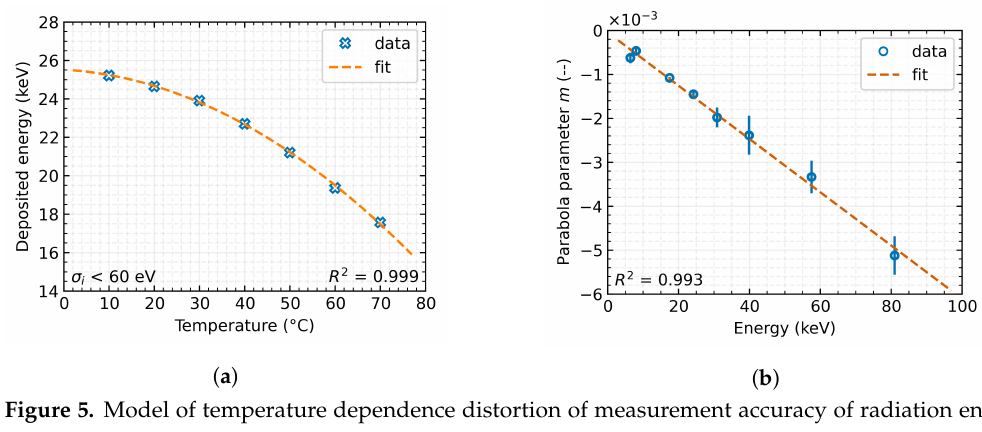
Figure 5. Model of temperature dependence distortion of measurement accuracy of radiation en- ergy spectrum (Time-over-Threshold in Data-driven mode) with Timepix3 detector equipped with 500µm Si sensor. The error bars indicate the inaccuracy of a given parameter obtained by the fitting function: ( a ) Temperature dependence; ( b ) Energy dependence.